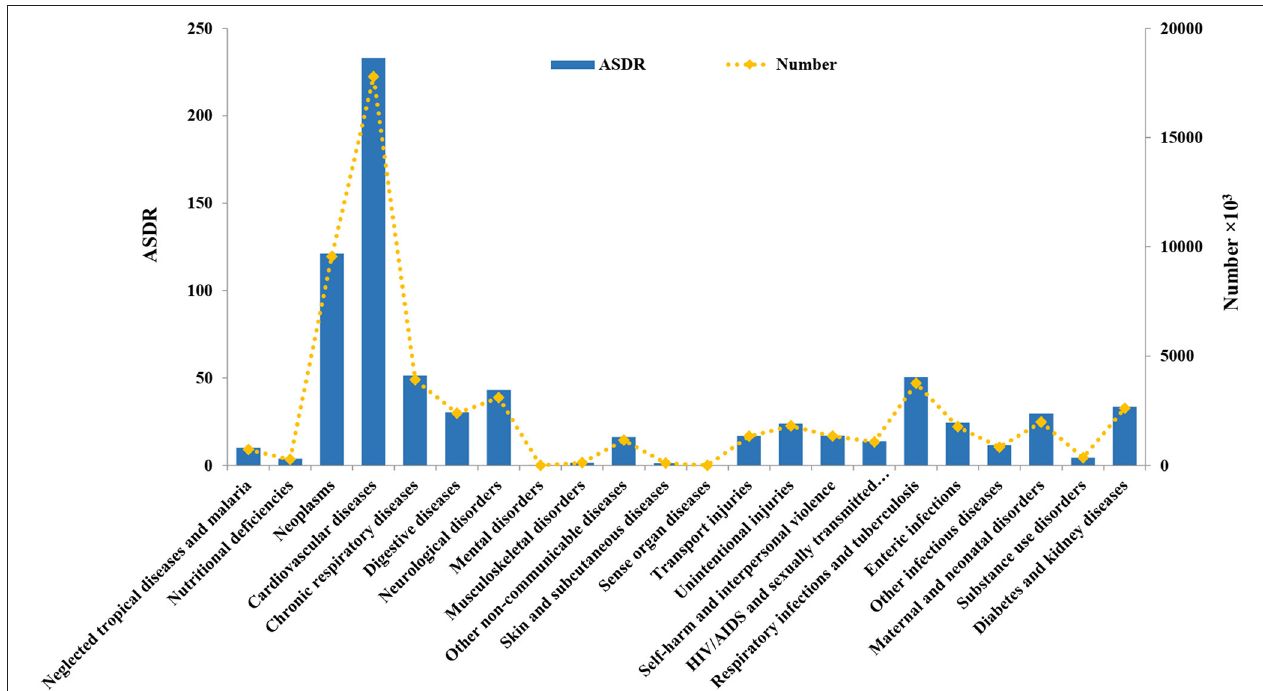
FIGURE 1 | The global age-standardized death rate (ASDR) and death number of 18 types of diseases in 2017.